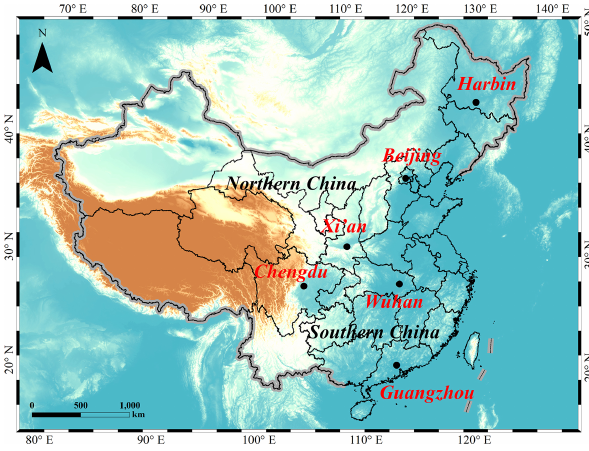
Figure 1. PM 2 . 5 samples were taken in six Chinese